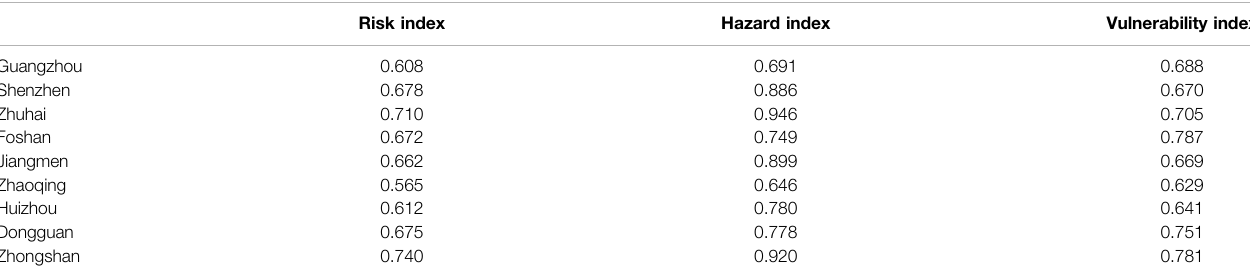
TABLE 8 | Risk, hazard, and vulnerability of typhoon – rainstorm disaster chain in cities of the